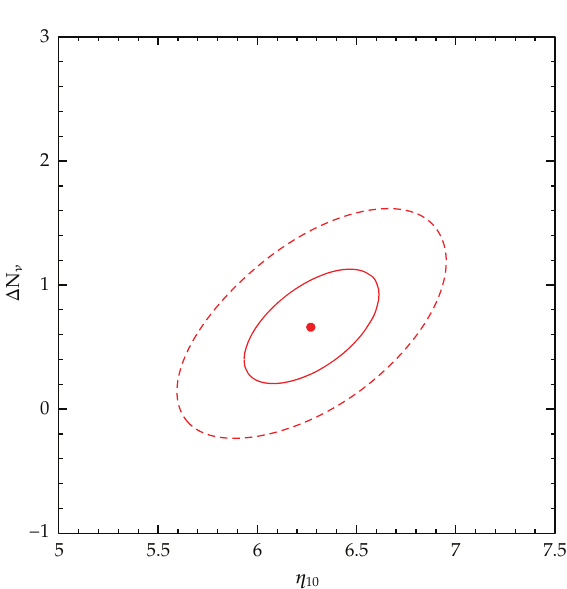
Figure 4: The BBN-inferred 68% (cid:3) solid (cid:4) and 95% (cid:3) dashed (cid:4) contours in the Δ N ν - η 10 plane derived from D and 4 He assuming that ξ (cid:7)